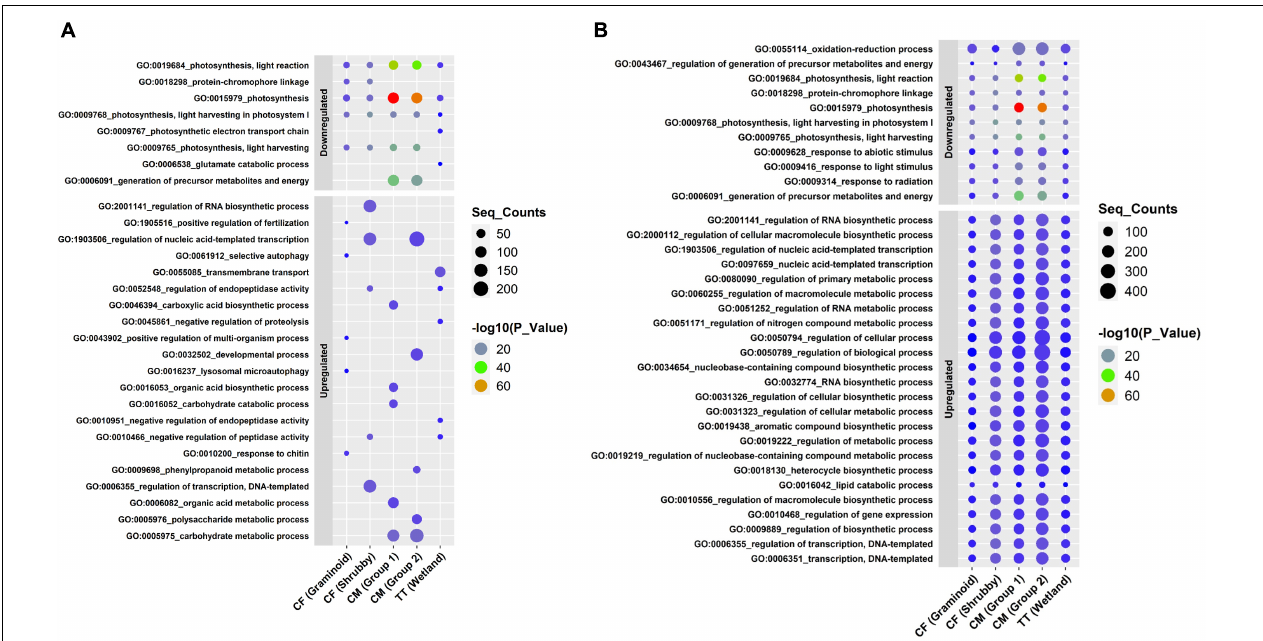
FIGURE 4 | Significantly enriched gene ontology (GO) terms annotated to differentially expressed genes (DEGs) of willow grown in different types of oil sands tailings with no reclamation cap or 5 cm of reclamation cap (treatments) compared with ≥ 30 cm of reclamation cap (controls). The top 10 highly enriched GO terms (biological process) in each group (A) and GO terms (biological process) shared among all groups (B) for CF, CM, and TT are shown. Significant enriched genes ( p -value < 0.05) are colored according to − log10 p -value and the dot size indicates the number of sequences annotated with GO term (Seq_Counts). CF, centrifuge tailings; CM, co-mix tailings; TT, thickened